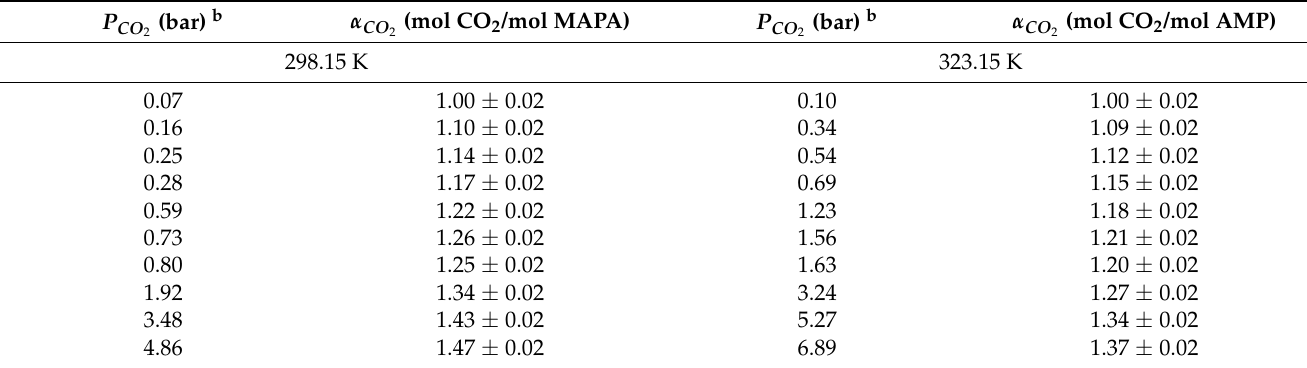
Table 7. CO 2 solubility in 30.0% wt. (3.36 M) MAPA aqueous solutions at 298–333 K a